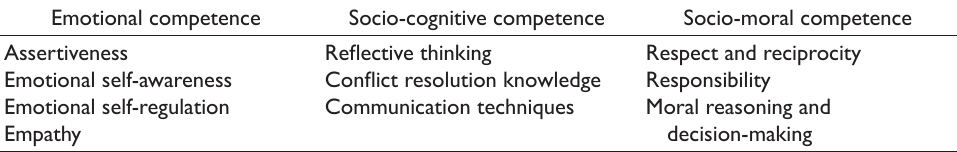
Table 1: Competence development through